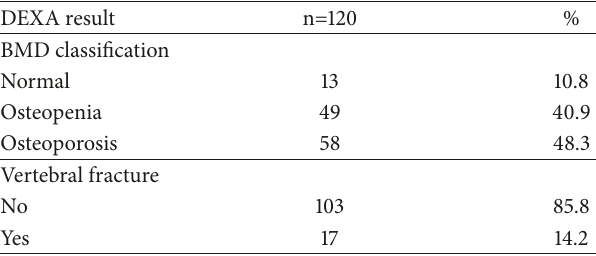
Table 2: Bone Mineral Density (BMD) classification and the prevalence of vertebral fractures.